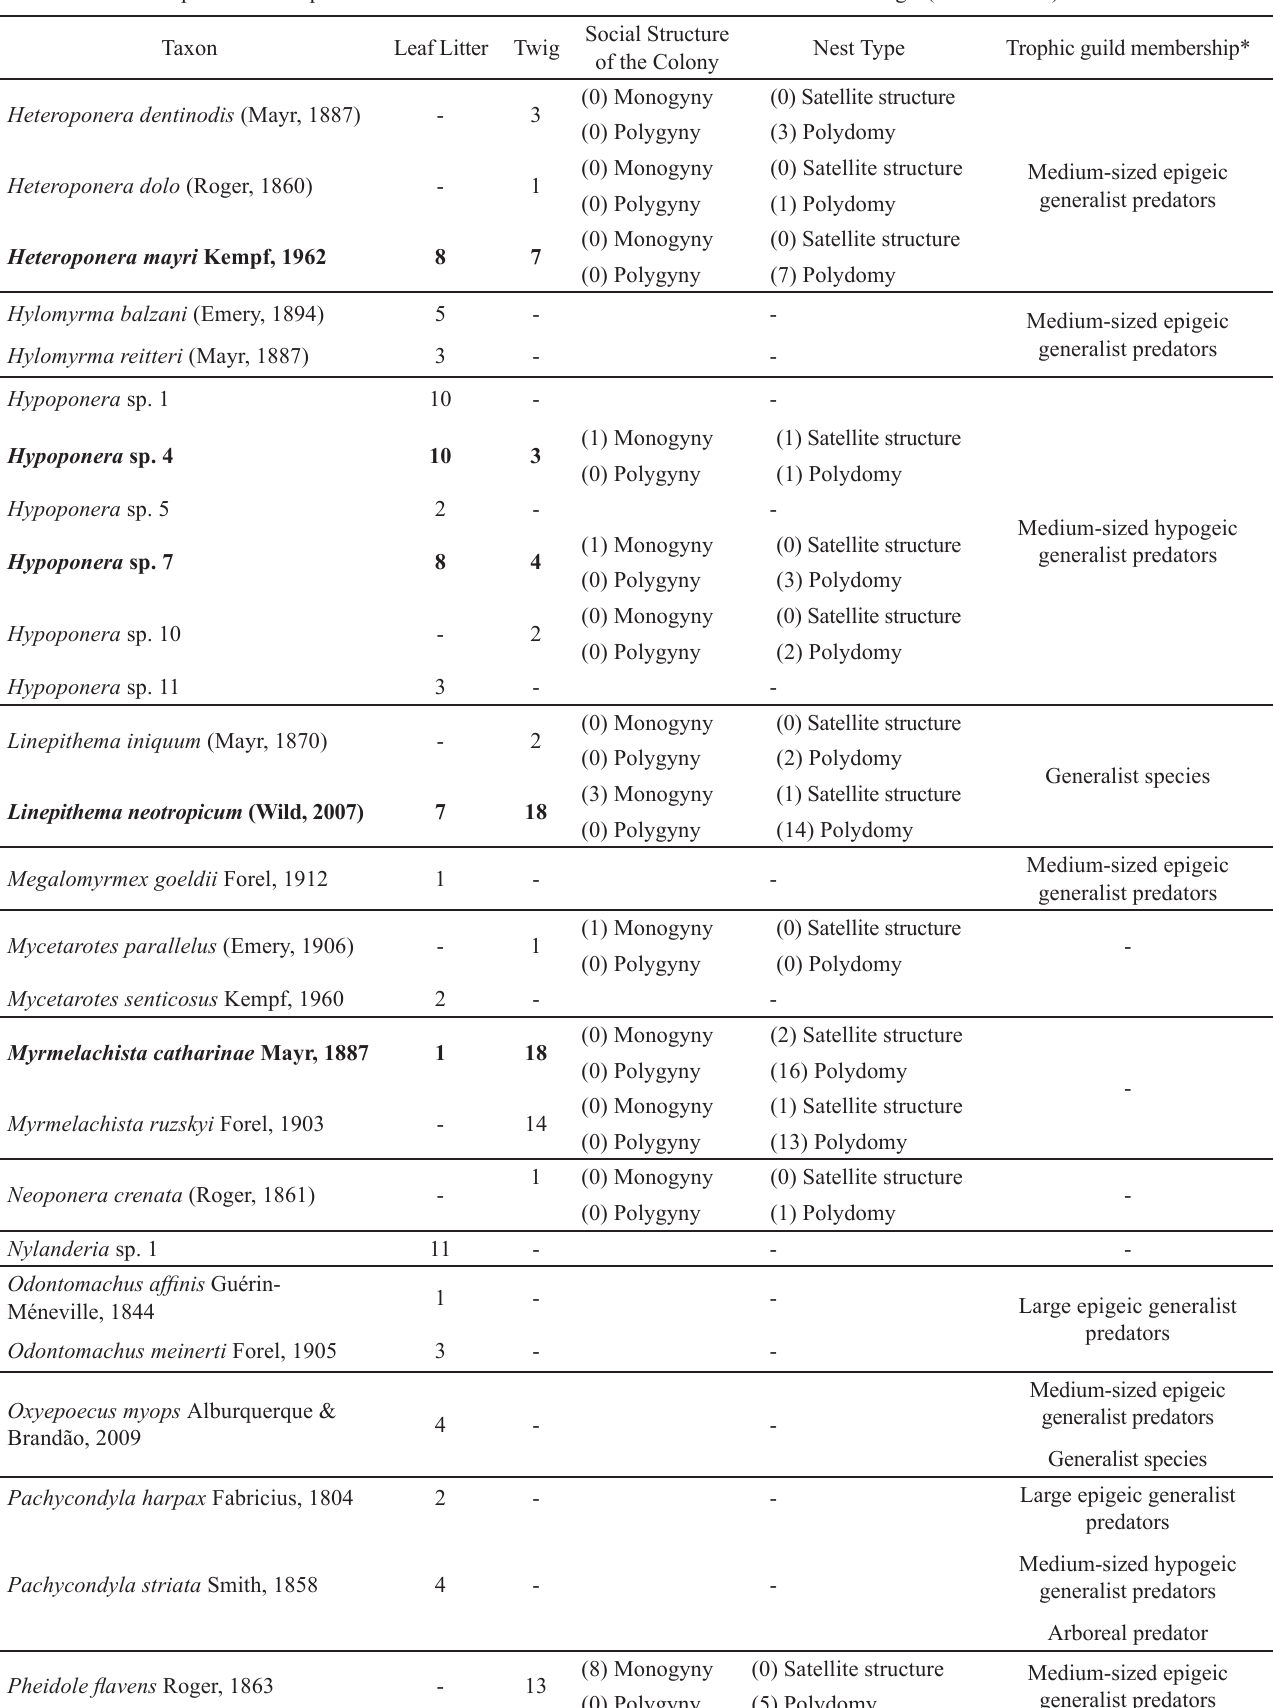
Table 1. List of taxa recorded from leaf litter and twigs, with social structure of the colony, nest type, and guild membership. The total number of nests is shown in parentheses. Species in bold font were recorded both in the leaf litter and in twigs.